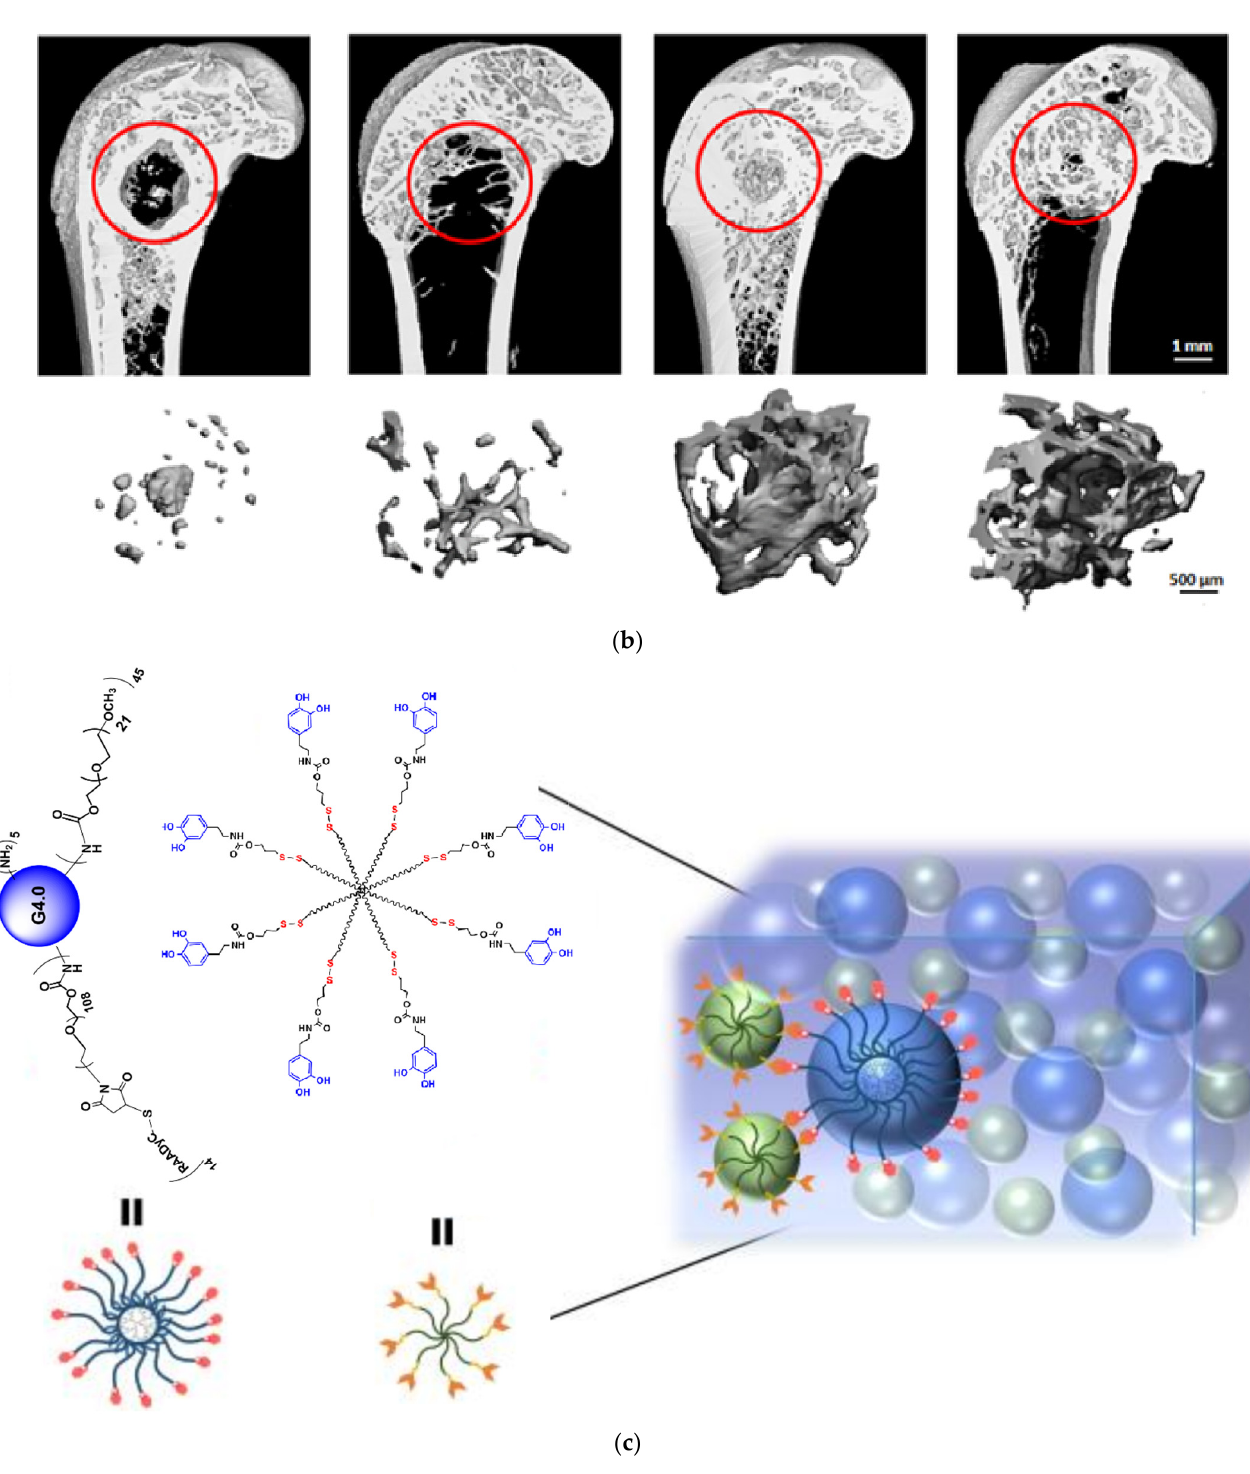
Figure 18. ( a ) Schematic diagram of the main steps of preparing bone injectable pastes for treating osteoporotic bone defect. ( b ) Reconstructed micro-computed tomography images of the coronal sections from the metaphyseal femur at week 12 (the red circles indicate new bone formation within a 3 mm diameter defect) and 3D reconstruction of the newly formed bone inside the defected area. Both were reproduced with permission from [203]. Copyright: American Chemical Society. ( c ) Schematic representation of the hydrogel from the aminoacid derivatives of the G4.0 PAMAM dendrimer and the PEG star polymer Reproduced with permission from [204]. Copyright: Royal Society of Chemistry.